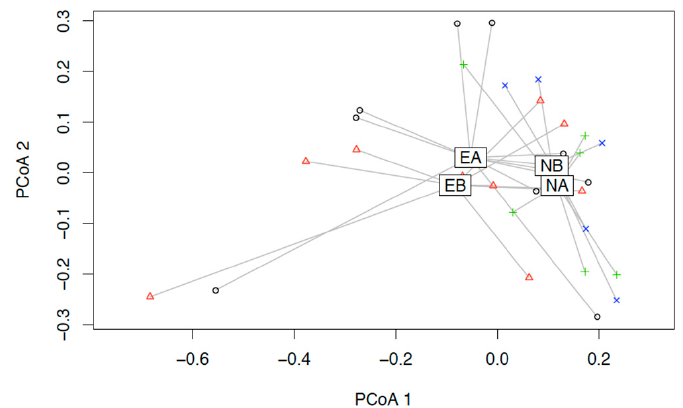
Figure 4. Unified Parkinson Disease Ratings Scale (UPDRS) III before and after one year after the 14 days interval of treatment for each individual group (enema, only nutrition) and for both groups together (pooled) (* p < 0.05; ** p < 0.01).